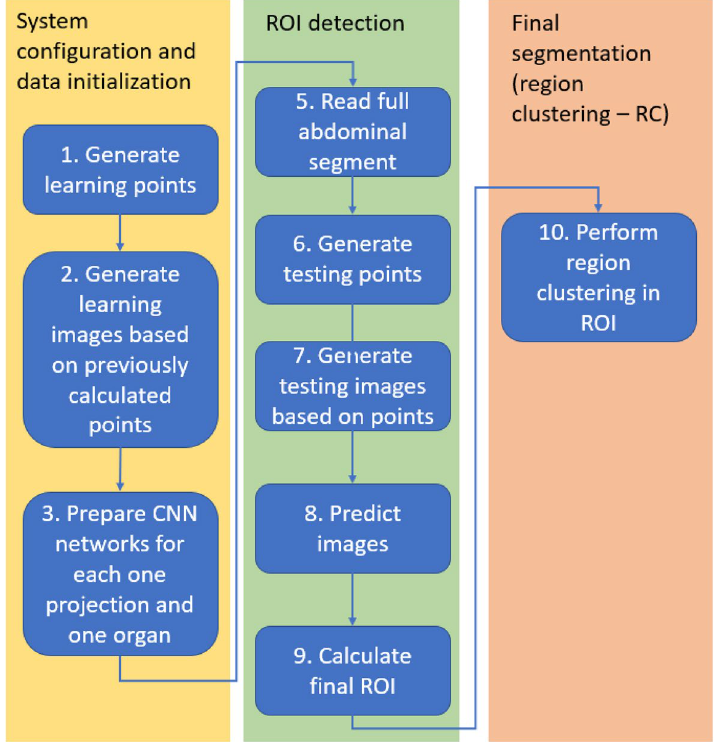
Figure 3. Workflow of the proposed system. The system consists of three main steps, from CT scan of the body to ROI and RC recognition: (1) system configuration and data initialization, (2) ROI detection (3) final organ